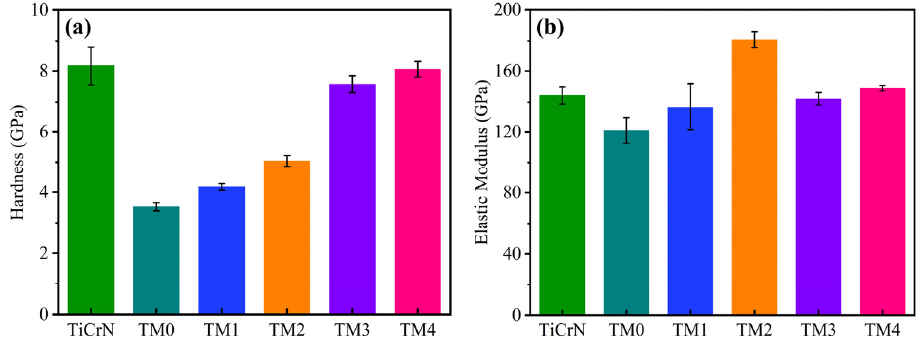
Figure 8. ( a ) Hardness and ( b ) elastic modulus of the coatings.